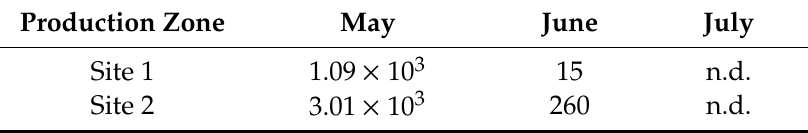
Table 4. Detection and quantification (in RNA copies / g) of HEV during the exploratory